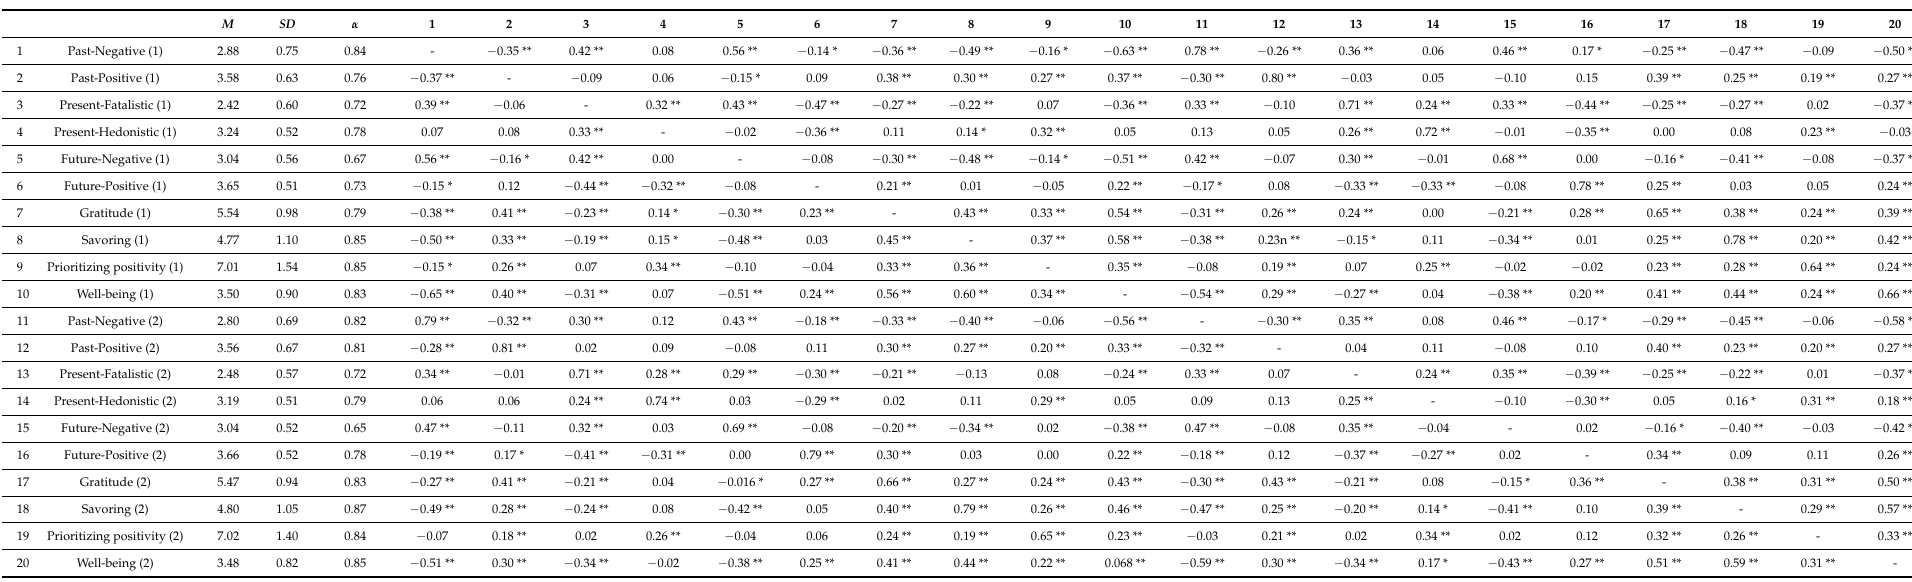
Table 1. Means, standard deviations, Cronbach’s alphas, and correlations between variables included in both waves (N =